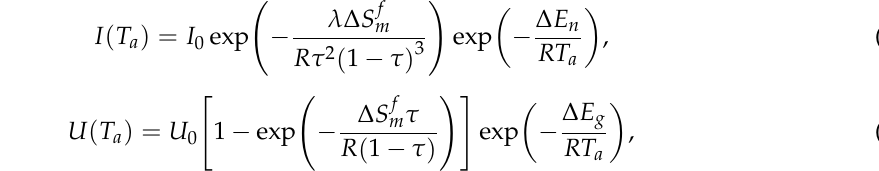
Figure 5. The relationship between mean grain size and annealing temperature for the (Fe 0.4 Co 0.6 ) 79 Nb 3 B 18